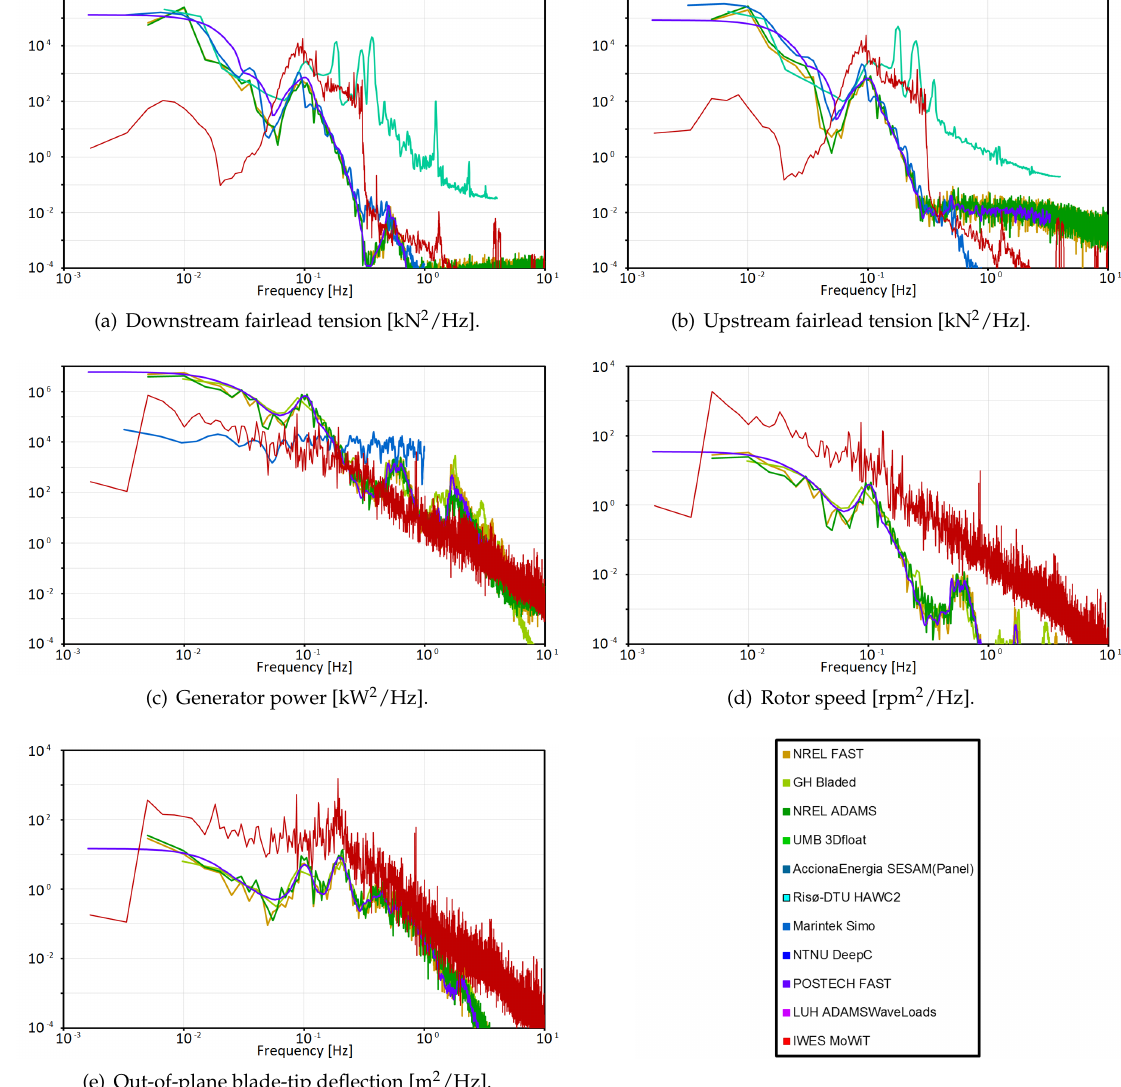
Figure 23. Aero-hydro-servo-elastic power spectra with irregular waves from LC 5.3, corrected for eliminating the deviations in the irregular wave and turbulent wind spectra, part